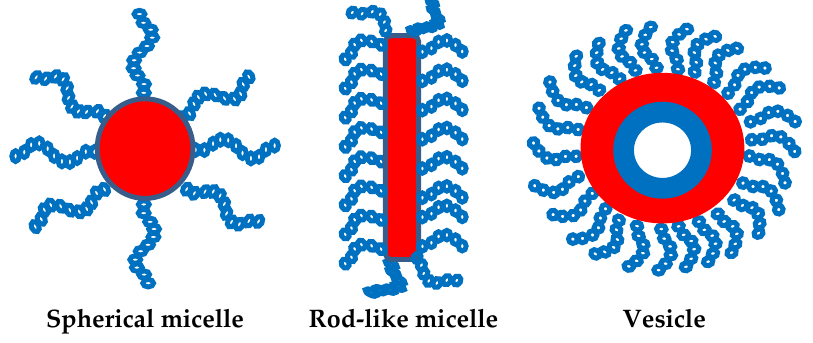
Figure 1. Basic micellar morphologies for AB copolymers.